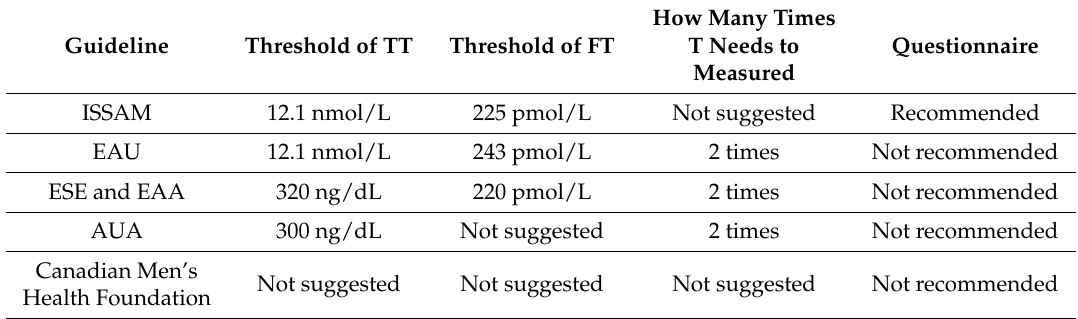
Table 2. The guidelines for the diagnosis of the optimal indication of treatment for